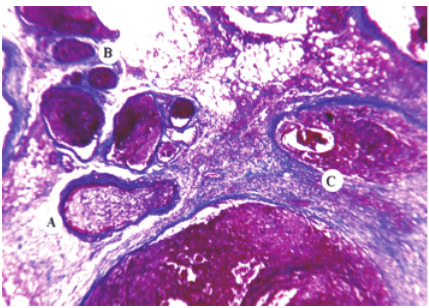
Figure 1: Interstitial swelling of pancreatic parenchyma. Microcir- culation peripheral thrombosis. H&E ( × 400).